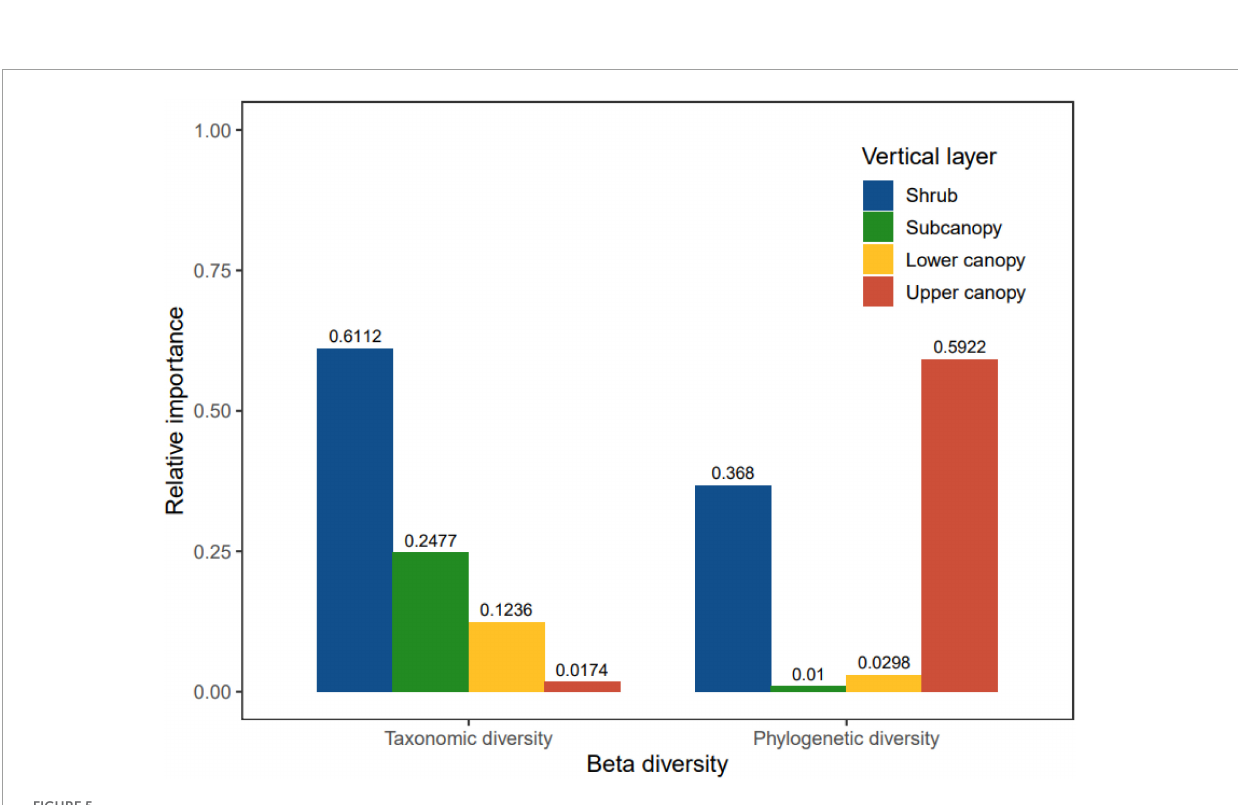
Frontiers in Ecology and Evolution